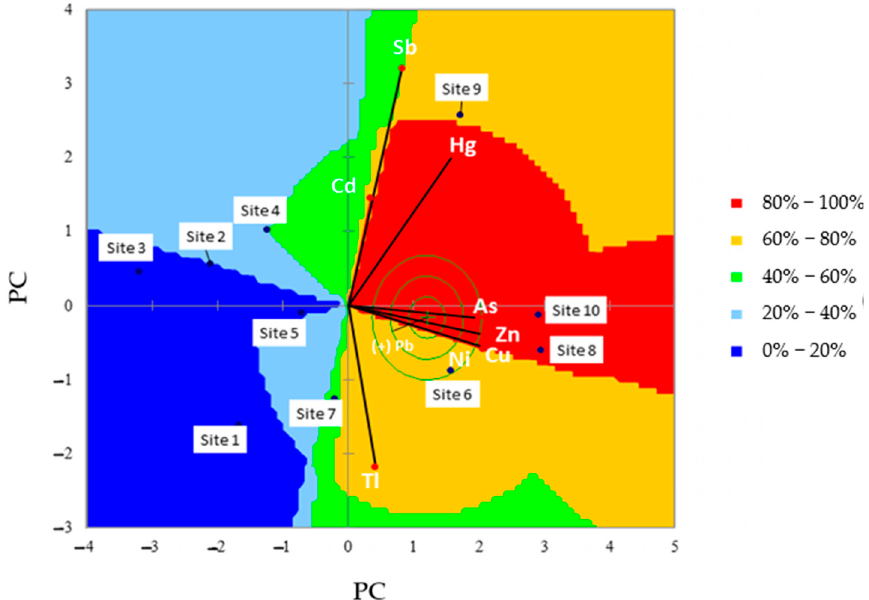
Figure 4. MDA contour plot as obtained by combining PCA and HCA results. Different colors account for the degree of similarity between the analyzed samples.